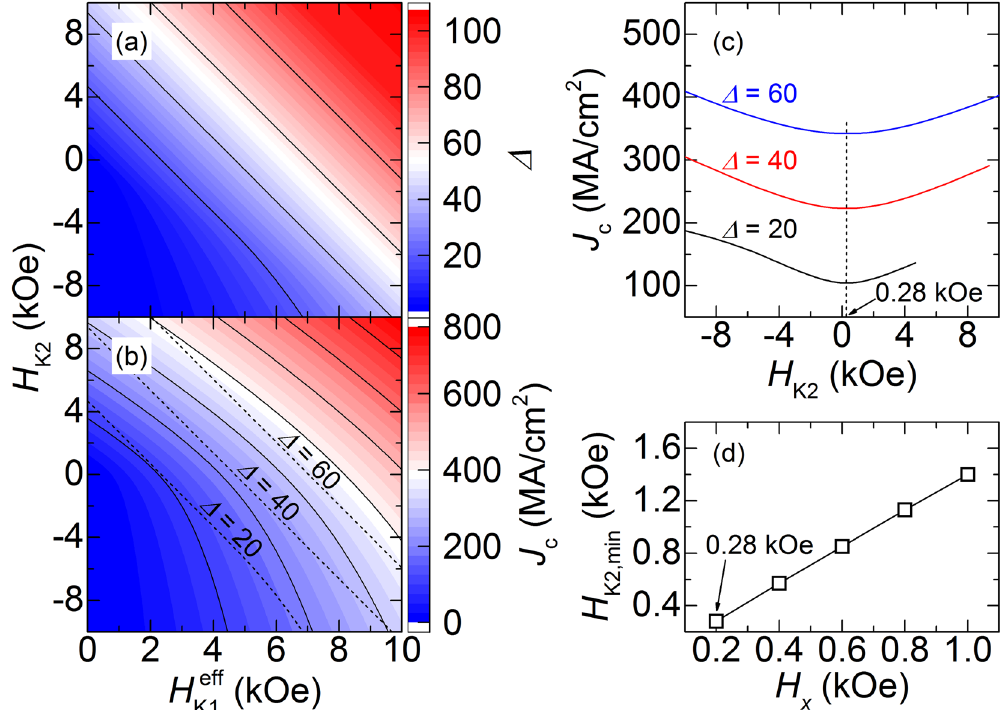
Figure 3. Analytical results for ( a ) Δ and ( b ) J c as functions of H K1eff and H K2 . Contour results for Δ at selected values of 20, 40, and 60 (dotted lines) are also shown in ( b ). ( c ) Analytical results for J c as function of H K2 at three different Δ values of 20, 40, and 60. In all cases, a broad minimum is observed at H K2 = 0.28 kOe. ( d ) Analytical results for H K2,min as function of H x